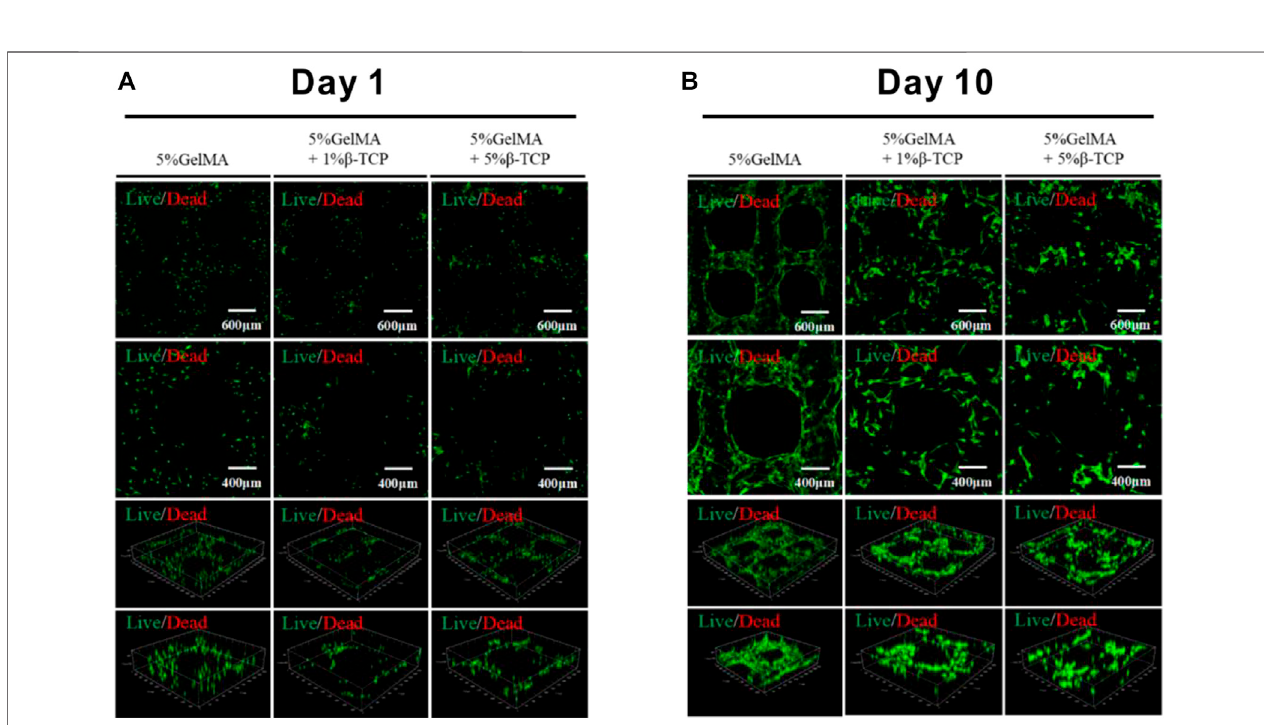
FIGURE 3 | Viability of BMSCs attached to the surface of hydrogel scaffolds. The surviving BMSCs attached to the different scaffolds were identi fi ed through immuno fl uorescence staining after incubation for 1 day (A) or 10 days (B) .